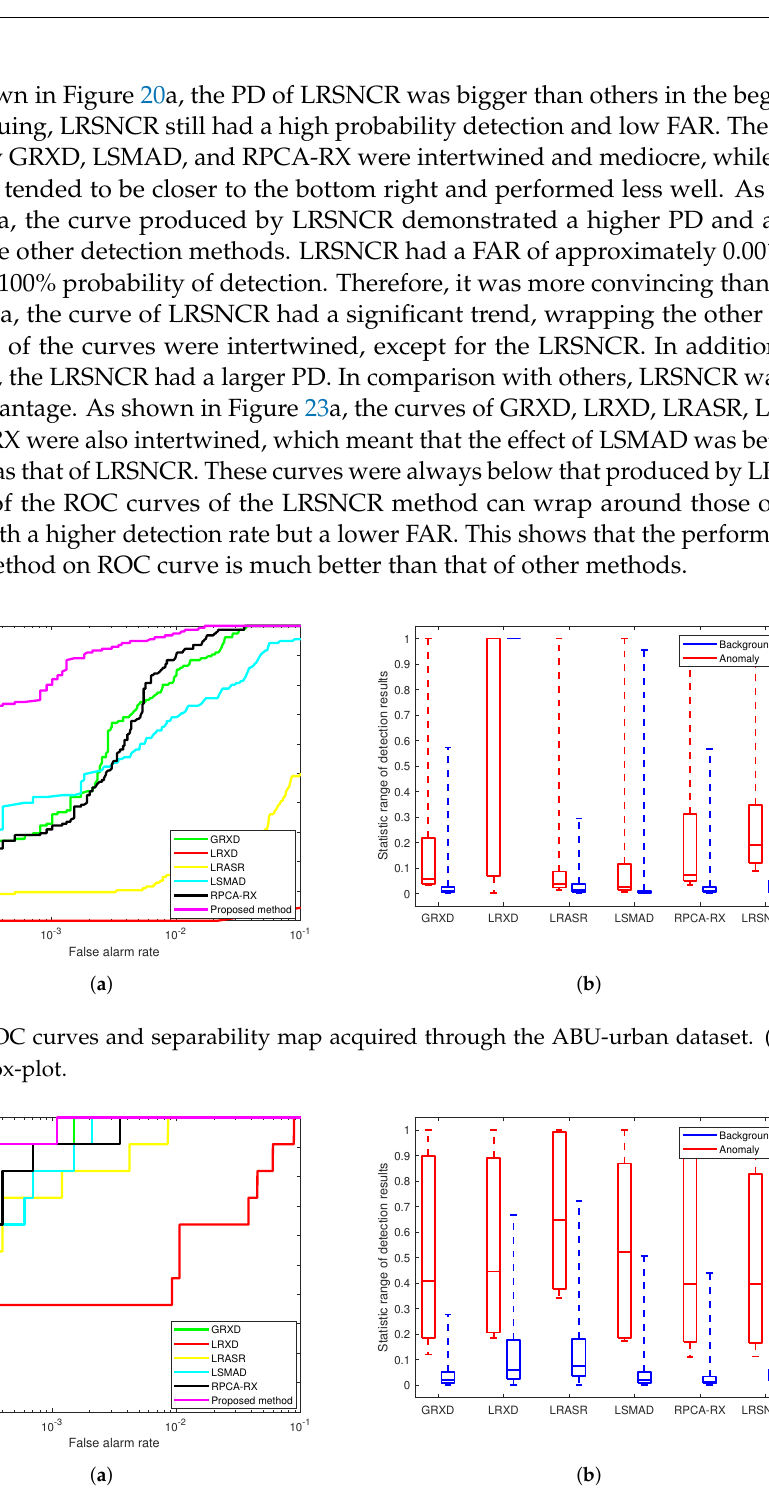
Figure 21. ROC curves and separability map acquire through the ABU-beach dataset. ( a ) ROC curves. ( b )